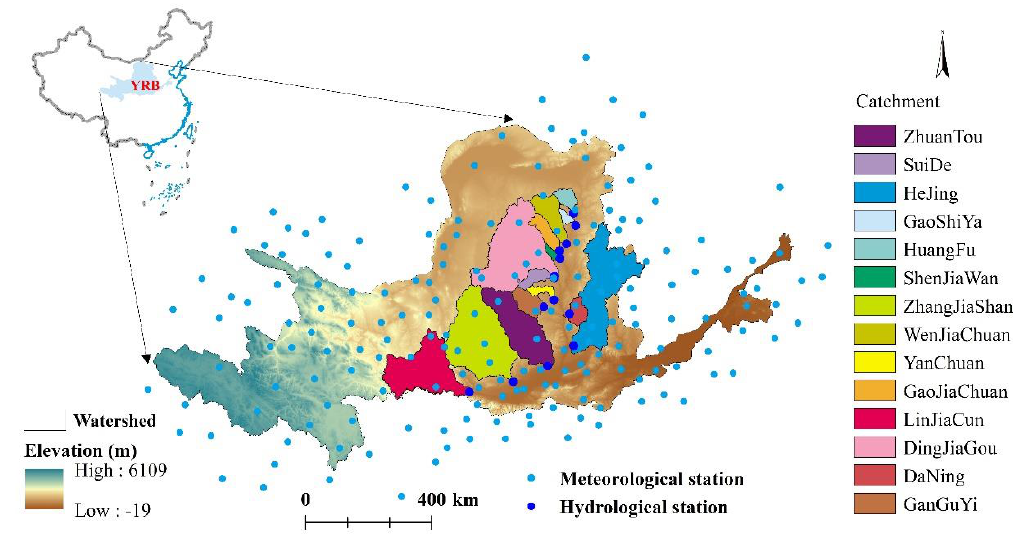
Figure 1. Study area: location, elevation, meteorological station s, and hydrological station s.